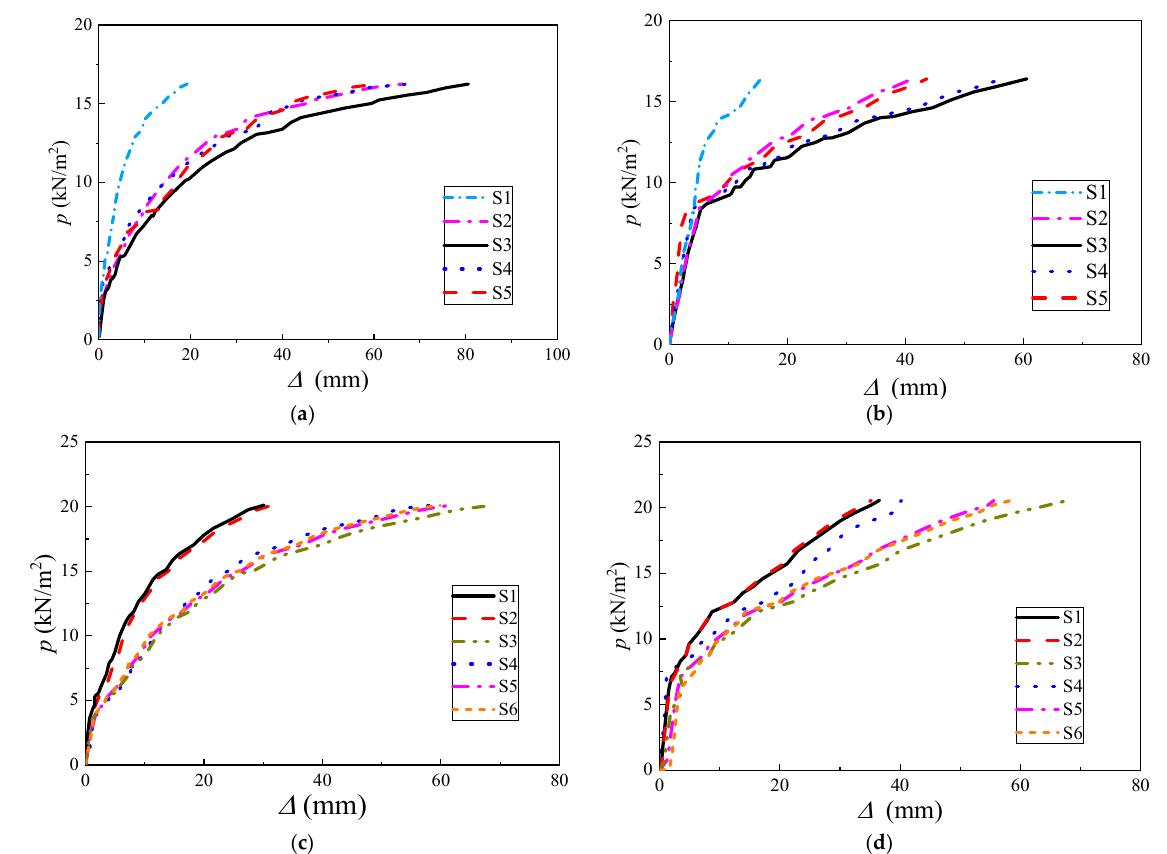
Figure 8. Load–deflection curves. ( a ) Specimen WP. ( b ) Specimen WN. ( c ) Specimen WPO. ( d ) Specimen WNO.